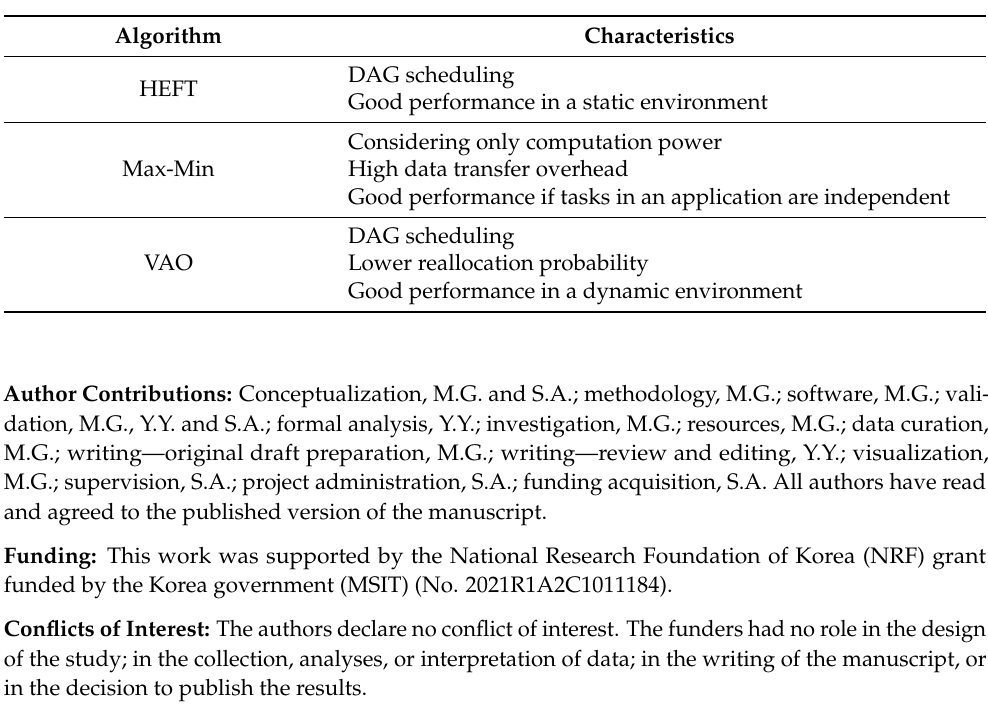
Table 3. Characteristics of task scheduling